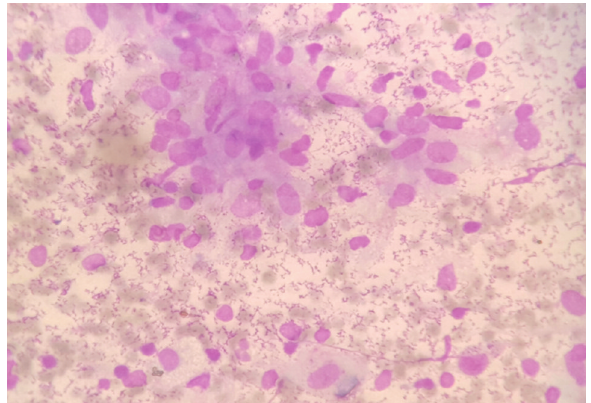
Epithelioid cell granuloma (MGG stain, x400). Fig. 3: